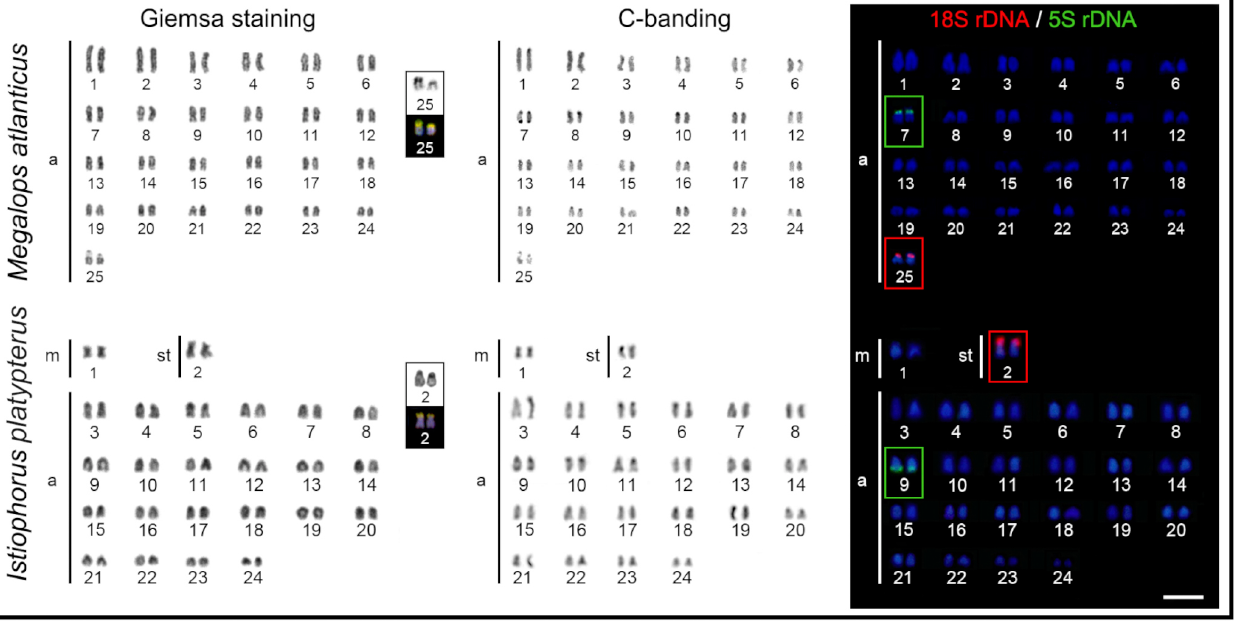
FIGURE 2 | Karyotypes of Megalops atlanticus (Megalopidae) and Istiophorus platypterus (Istiophoridae) after Giemsa staining, C-banding and FISH procedures. The small left boxes highlight the Ag-NORs and MM+/DAPI- sites, and the right ones the 18S (red) and 5S (green) rDNA sites. Scale bar = 5